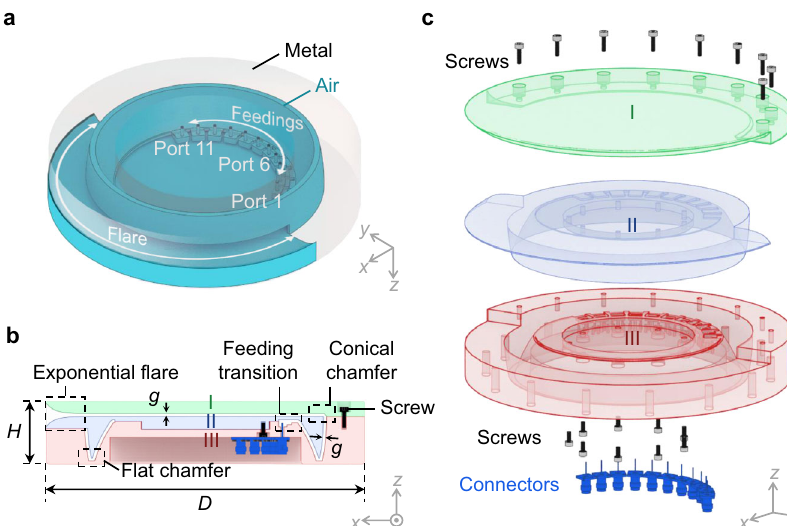
Fig. 7 Implemented antenna structure. a Perspective view of the functional hollow volume, b cross-sectional view, c isometric exploded view. The total diameter of the antenna is D = 200 mm, and the total height is H = 40 mm. The dimensional parameters of the lens pro fi le are h 0 = 1.23, p = 1.77, q = 2.28, ρ 0 = 0.78, with lens radius R = 75 mm, and PPW height g = 2